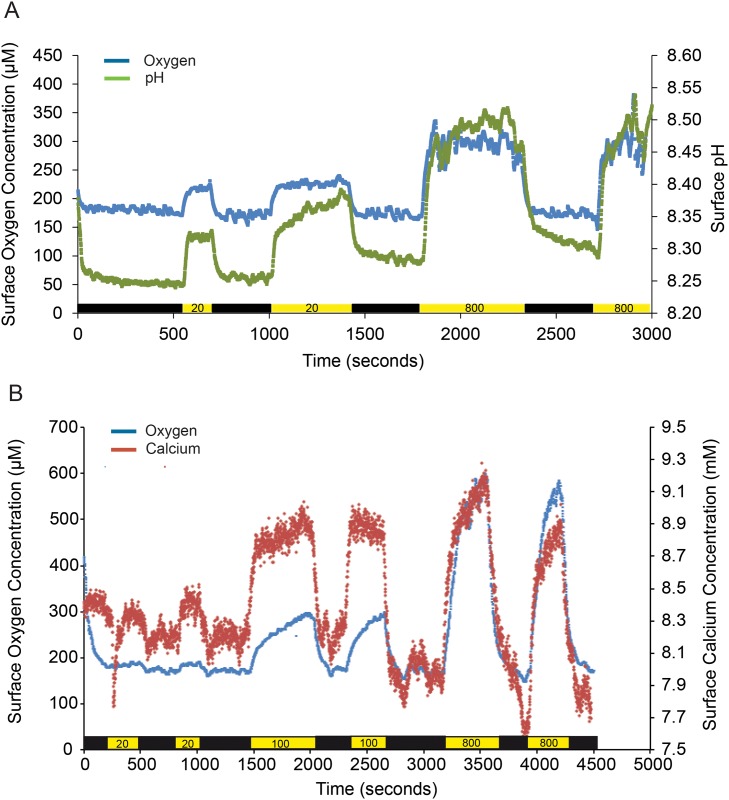
O2, pH and Ca2+ dynamics.Simultaneous A) oxygen (blue) and pH (green) dynamics and B) oxygen (blue) and calcium (red) dynamics measured at the surface of a single individual (CCA III) at 20 and 100 and 20, 100 and 800 μmol photons m-2 s-1 light intensities, respectively. The light intensities are indicated in the yellow boxes along the x-axis, and the black boxes indicate darkness. Note the lengths of the x-axes differ.